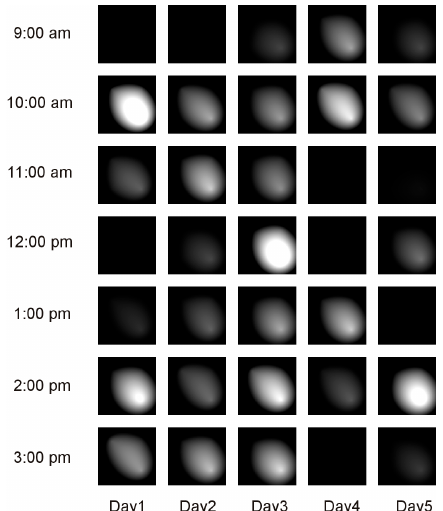
Figure 8. A fragment of the activity map built with hourly images of the pheromone distributions.